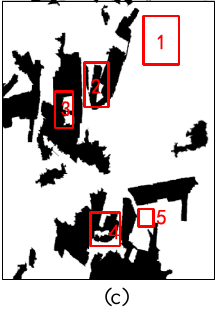
Figure 10. The comparison of change detection results, (a) original method, (b) a=0.6, b=0.4, (c) a=0.7, b=0.3